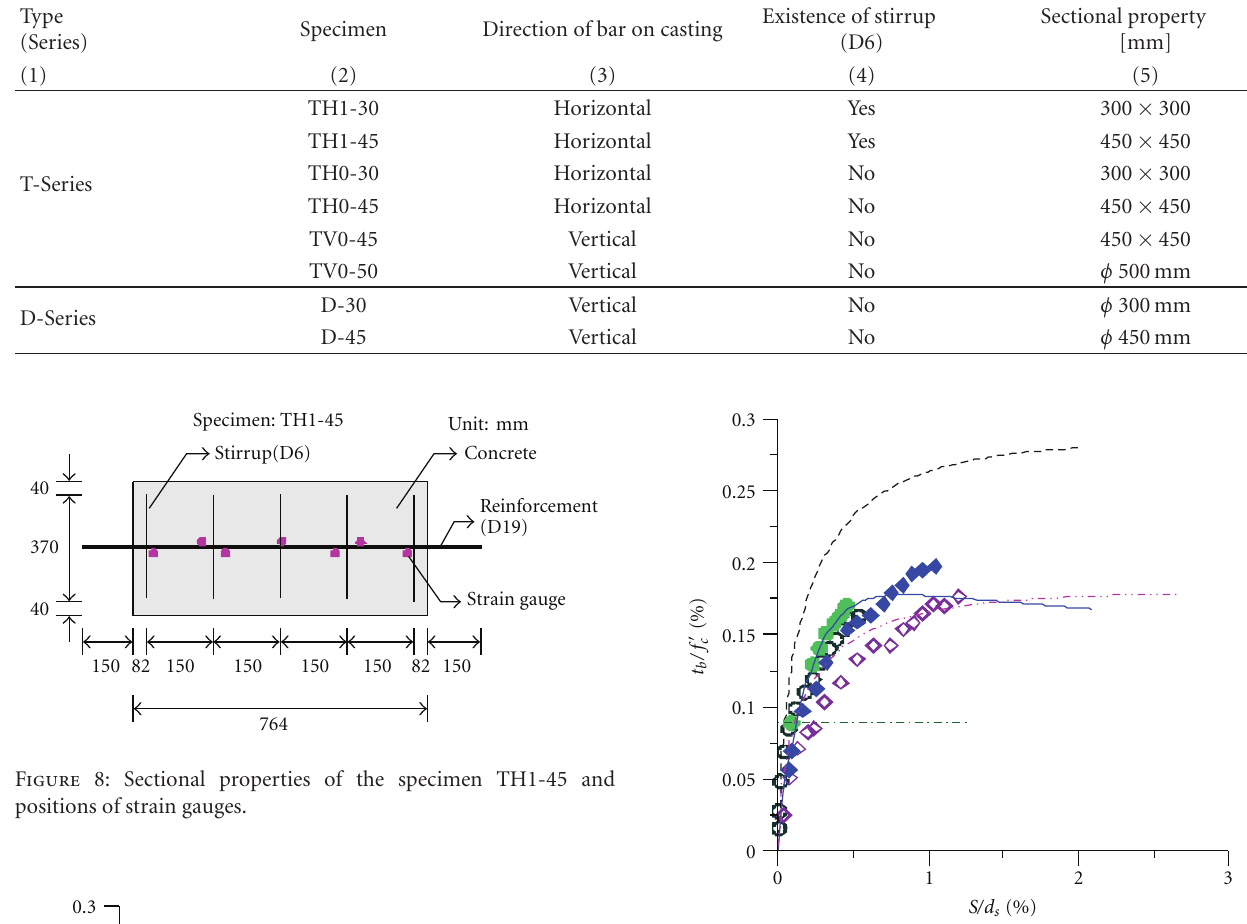
Table 1: Properties of test specimen.